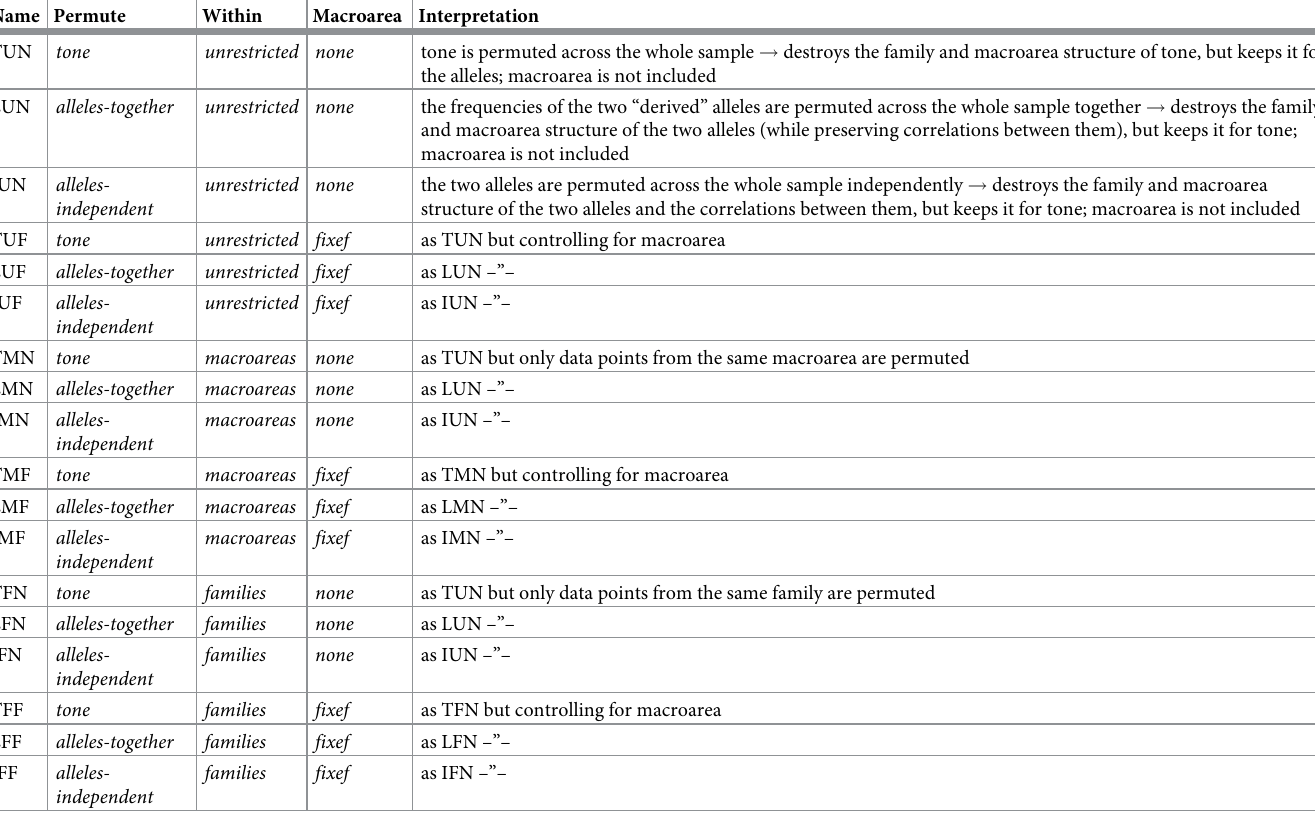
Table 7. The 18 randomisation scenarios. Parameter names and values (columns 2–3) are defined in Table 6, Name (1 st column) is a 3-letter shorthand: 1 st letter: T = tone, L = alleles-together (“linked”) and I = alleles-independent (“independent”); 2 nd letter: U = unrestricted, M = macroareas, F = families; 3 rd letter: N = none, F = fixef. –”– means as